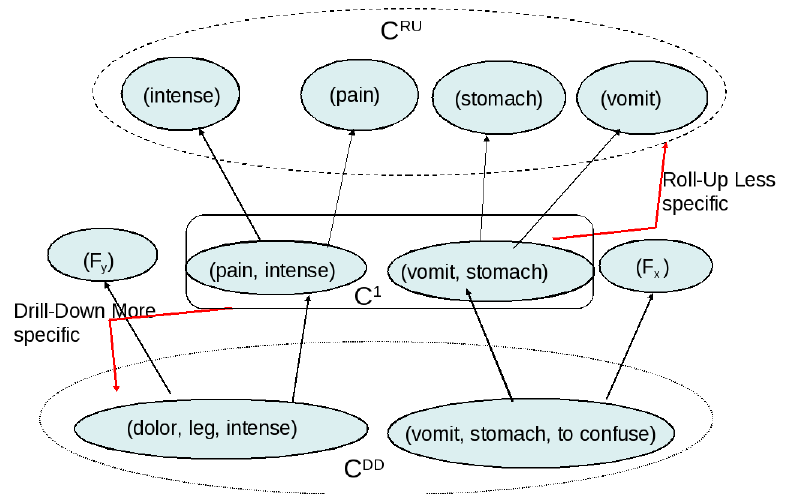
Figure 3: Roll-Up y Drill-Down examples over a hierarchy of